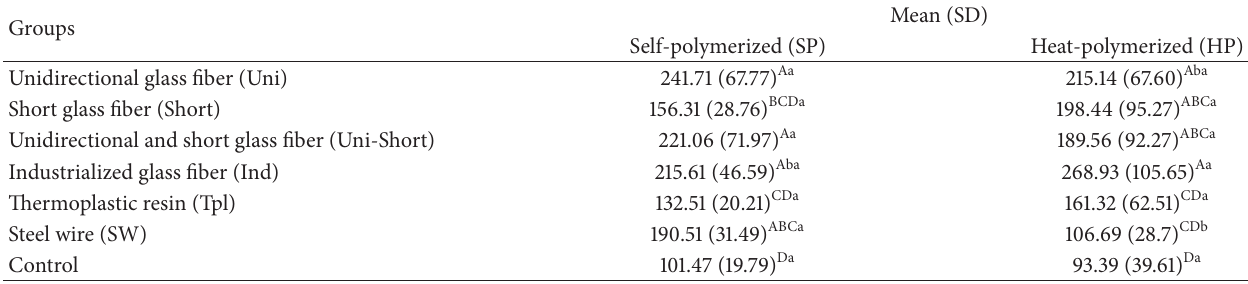
Table 2: Flexural strength means and standard deviations (MPa) for different polymerization and reinforcement methods.